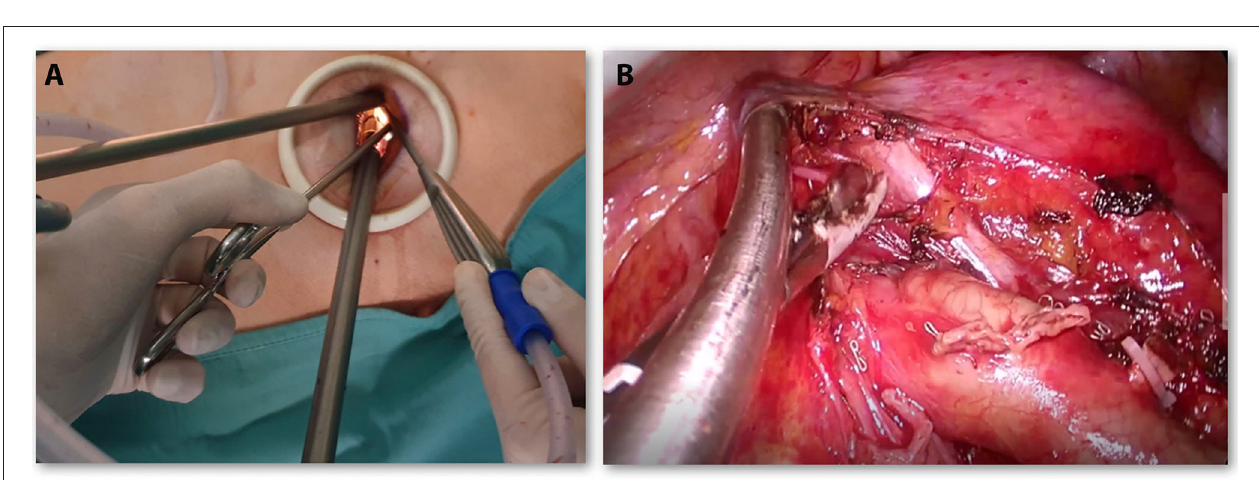
FIGURE 2 | (A) Placement of endoscopic instruments through Uniportal—Video-Assisted thoracic surgery (VATS) incision. (B) U-VATS surgical view during the left side (station 5, 6) lymphadenectomy. as numbers (%). Continuous variables were expressed as mean ± SD, or medians if non-normally distributed. Categorical variables were compared by Chi-square test; continuous variables by the independent- sample Student’s t -test or the Mann–Whitney U -test, as appropriate. Univariate linear